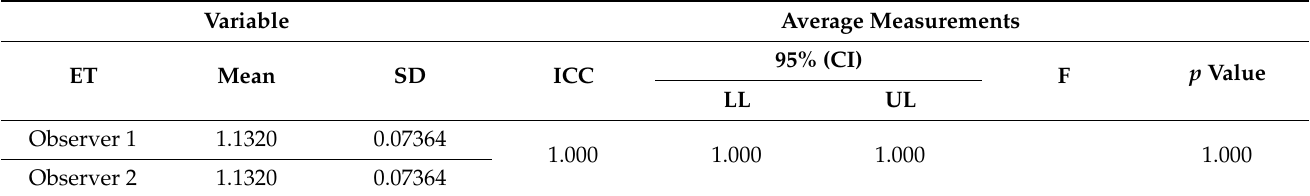
Table 8. Values in the ICC in the interobserver assessment of Execution Time (ET) and average measurement.